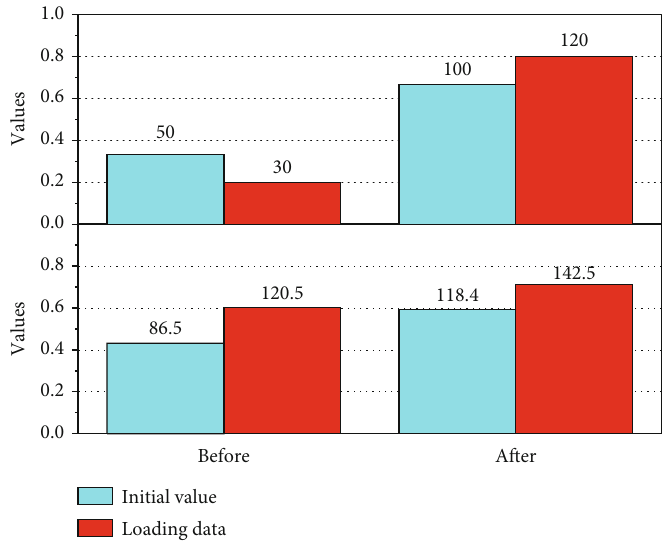
Figure 2: Overall variance explanation table for psychological capital.